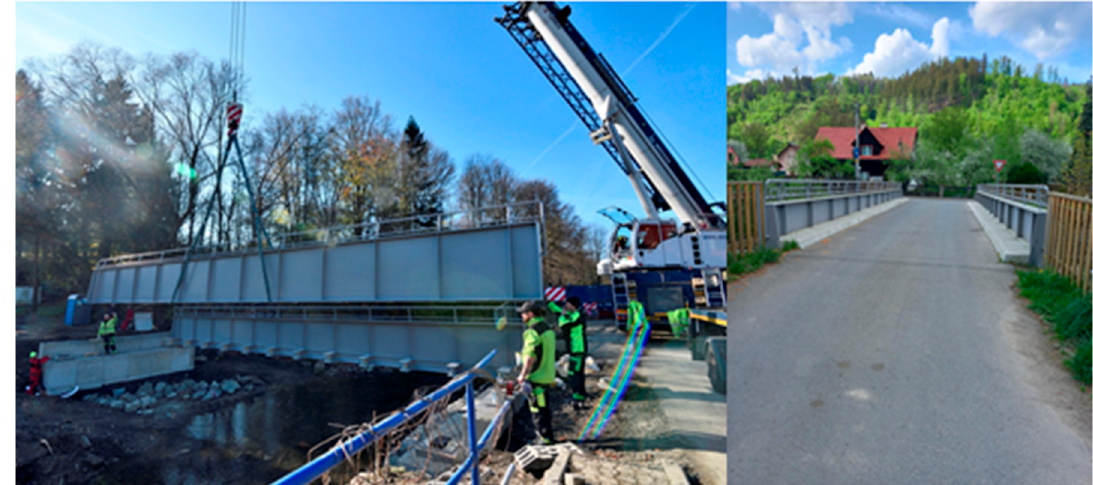
Figure 4. Digital picture of SCB bridge.